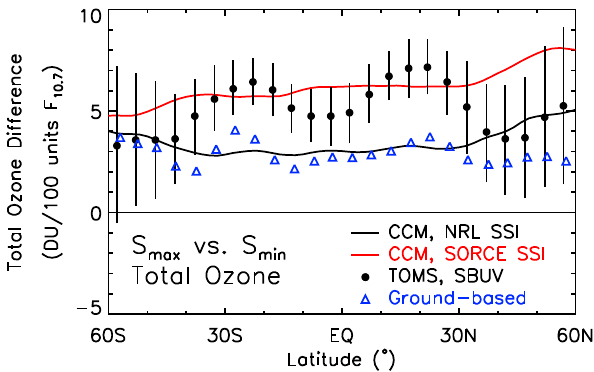
Fig. 6. Total ozone response to the 11-yr solar cycle, as modeled by the GEOSCCM and inferred from observations by regression analyses of the TOMS, SBUV merged total ozone dataset (Stolarski et al., 2006, Fig. 6) and ground-based observations (Randel and Wu, 2007, Fig. 12).